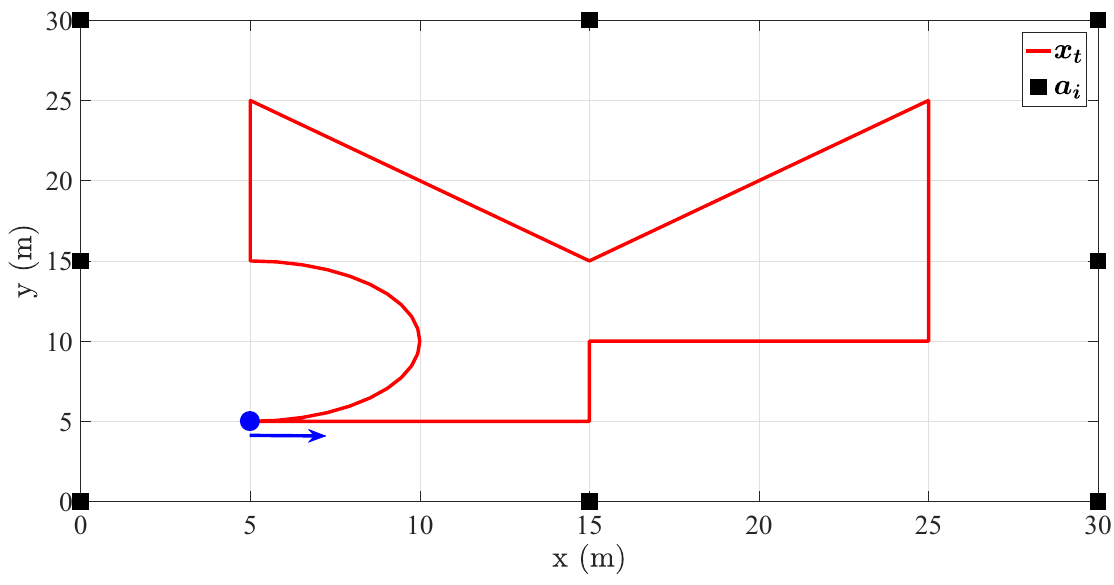
Figure 3. The considered target’s trajectory: the initial target’s location and its direction of movement are indicated by the circle and the arrow,